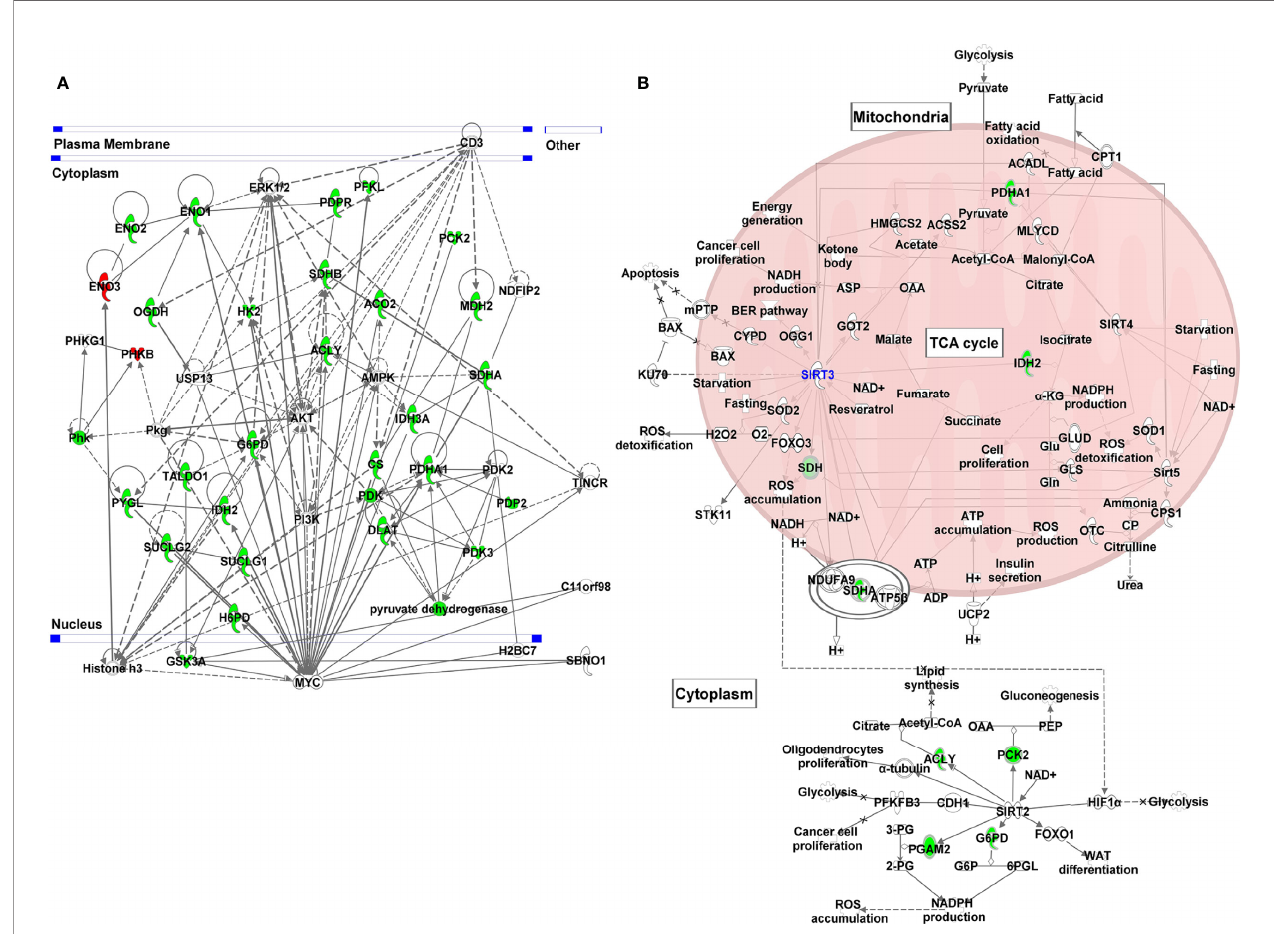
FIGURE 5 | Gene network and canonical pathway analyses of glucose metabolism genes identi fi ed in response to SIRT3 knockdown (shSIRT3- SK-MEL-2). Differentially expressed genes from glucose metabolism PCR array with cut-off criteria of ≥ 1.96-fold change with statistically signi fi cant change were analyzed using IPA. (A) Gene network indicating complex interactions among SIRT3 modulated genes and with several cancer/melanoma-associated genes. (B) Canonical pathway showing the interaction of SIRT3 with some of the SIRT3-modulated genes along with other sirtuins. Genes are represented with green (downregulated) or red (upregulated) or no color (appeared during gene network analysis). Solid lines indicate robust interactions, and dashed lines are signi fi cant but less